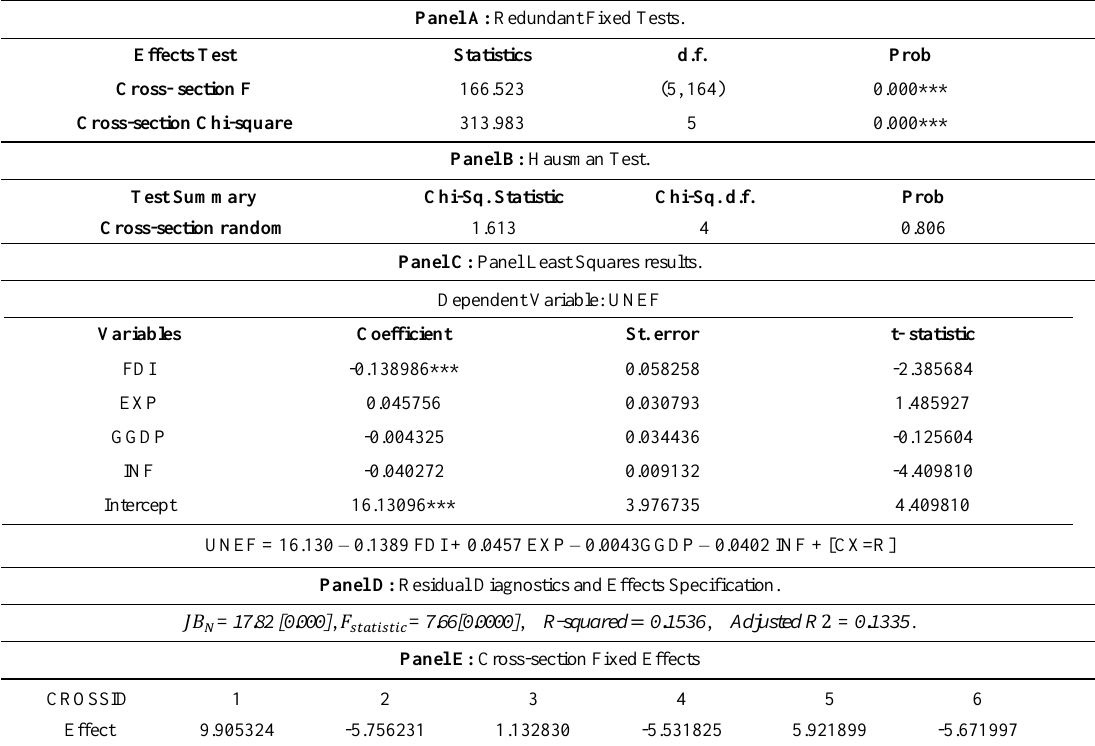
Table 10. Random Effect Model (REM) estimation and test